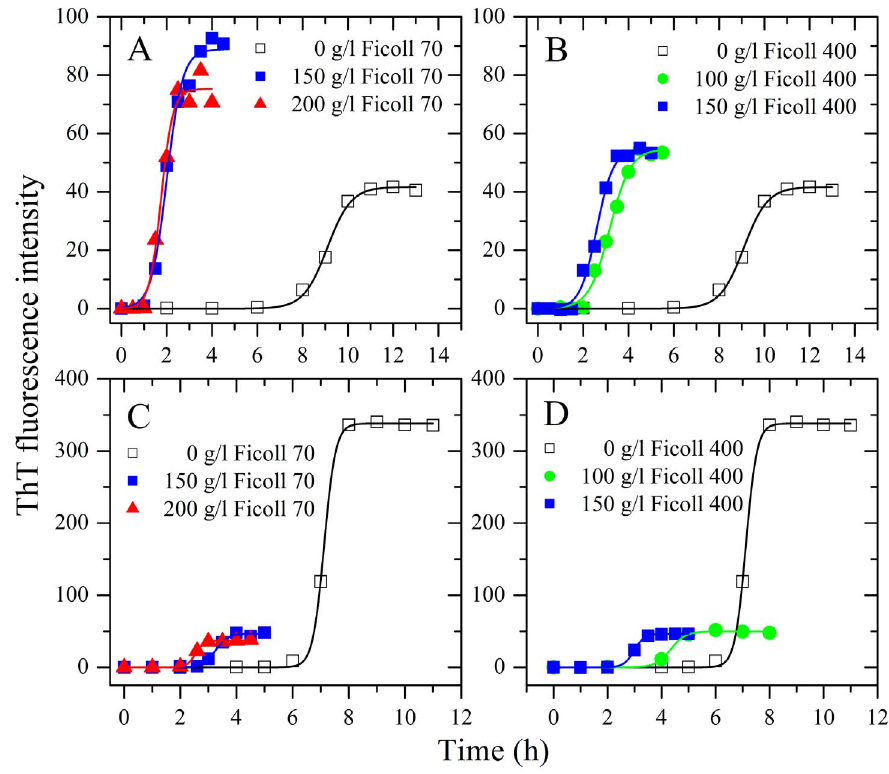
Figure 1. Effects of macromolecular crowding on amyloid formation of human chimera and rabbit chimera of prion proteins. Human chimera (A and B) and rabbit chimera (C and D) in the absence and presence of Ficoll 70 (A and C) or Ficoll 400 (B and D), monitored by ThT fluorescence. All experiments were repeated at least three times. The final concentrations of all prion proteins were 10 m M. The crowding agent concentrations were 0 (open square), 100 g/l (solid circle), 150 g/l (solid square), and 200 g/l (solid triangle), respectively. A sigmoidal equation was fitted to the data and the solid lines represented the best fit. The corresponding kinetic parameters from A–D are summarized in Table 1. doi:10.1371/journal.pone.0113238.g001 The method for fibrillization of PrP-H2H3 was similar to the containing 200 mM NaCl and 1 M GdnHCl in the absence and method described by the Rezaei lab [30]. Because urea is not presence of crowding agents with continuous shaking at 220 rpm, stable at pH 5.0, we modified the method as follow: 10 m M PrP- and samples (50 m l) were diluted into NaAc buffer buffer H2H3 was incubated at 37 u C in 20 mM NaAc buffer (pH 5.0) containing 12.5 m M ThT, giving a final volume of 2.5 ml.